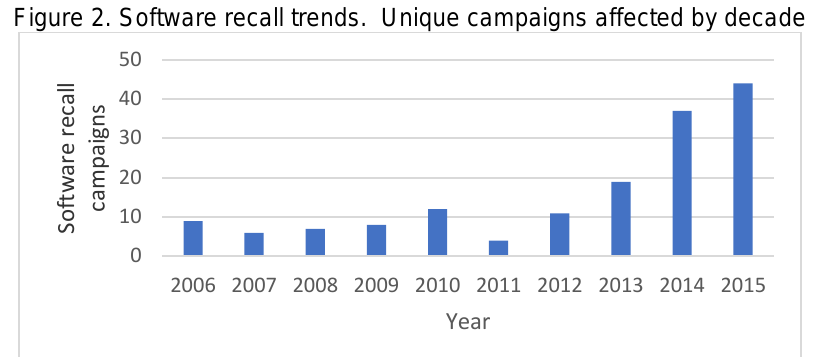
Figure 2. Software recall trends. Unique campaigns affected by decade